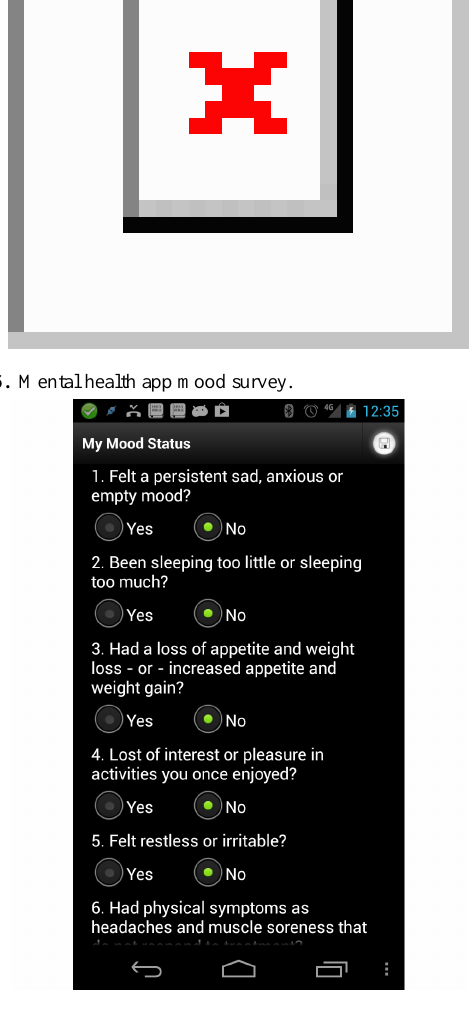
Figure 5. Skincare app affected area selection.